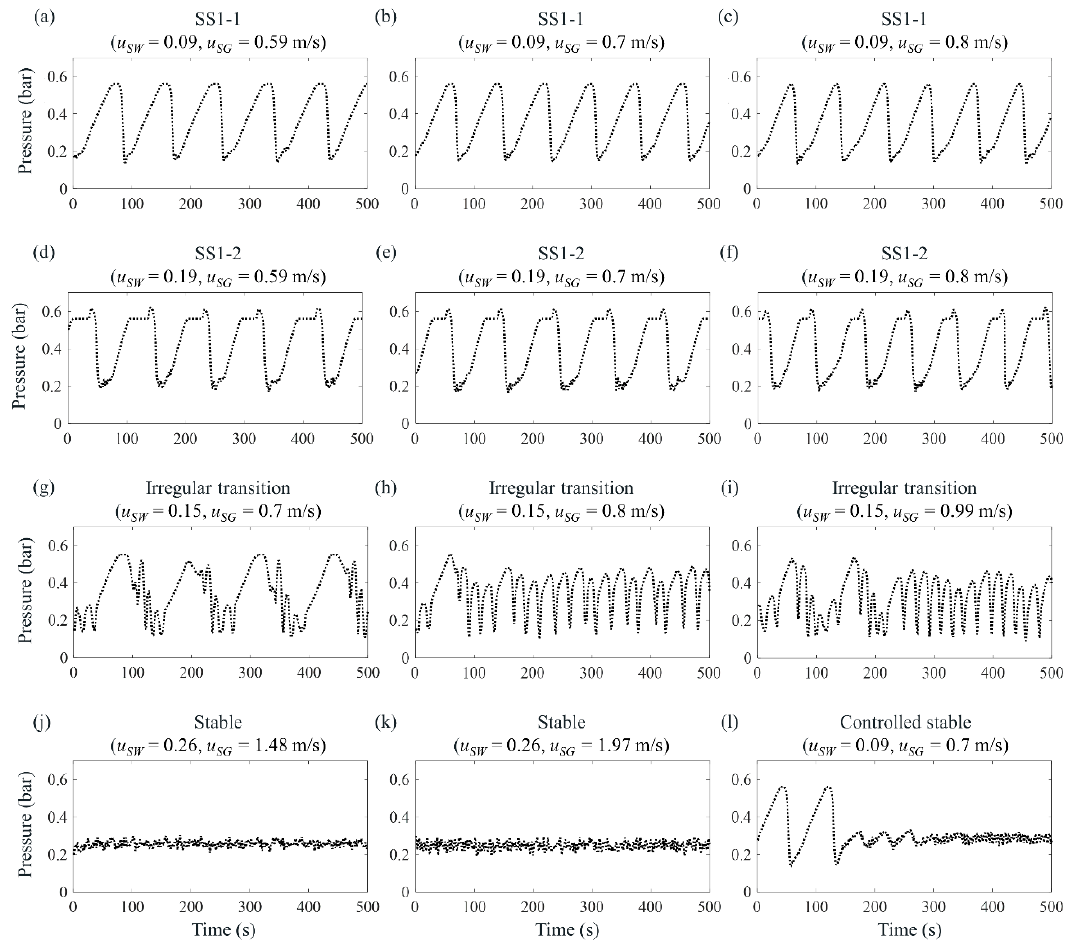
Figure 4. Measured pressure at the riser base for each flow regime: ( a – c ) SS1-1 at u SW = 0.09 m / s with u SG = 0.59, 0.7, and 0.8 m / s; ( d – f ) SS1-2 at u SW = 0.19 m / s with u SG = 0.59, 0.7, and 0.8 m / s; ( g – i ) irregular transition between SS3 and DFSS at u SW = 0.15 m / s with u SG = 0.7, 0.8, and 0.99 m / s; ( j – k ) stable flow at u SW = 0.26 m / s with u SG = 1.48 and 1.97 m / s; and (l) controlled stable flow after SS1-1 generation at u SW = 0.09 m / s with u SG = 0.7 m /